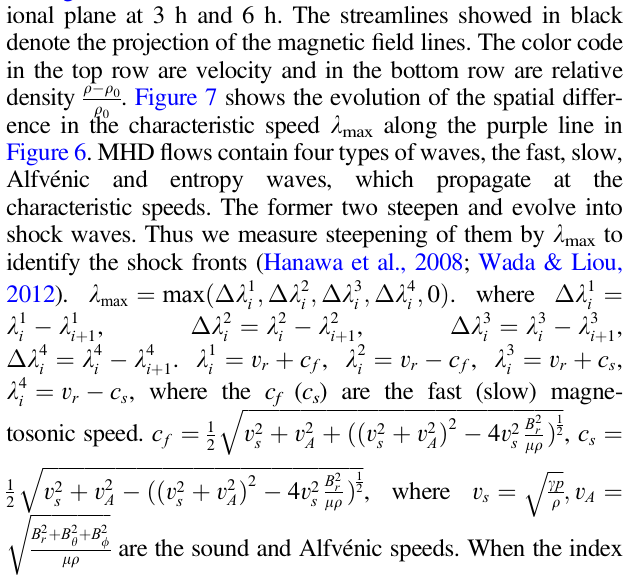
are the sound and Alfvénic speeds. When the index